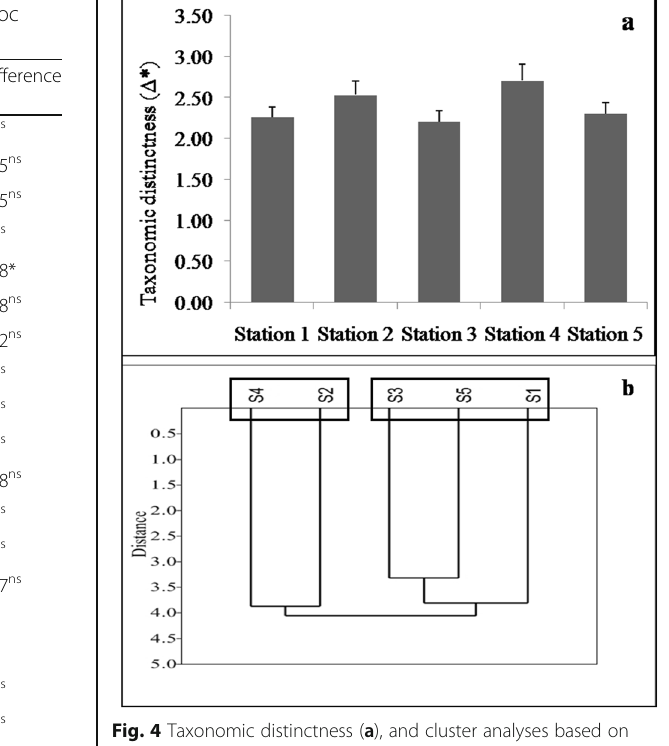
file 2: Figure S3a – S3e). Depth and water discharge were lowest during the late flood phase, while width and cross- sectional area were lowest during the early flood phase.